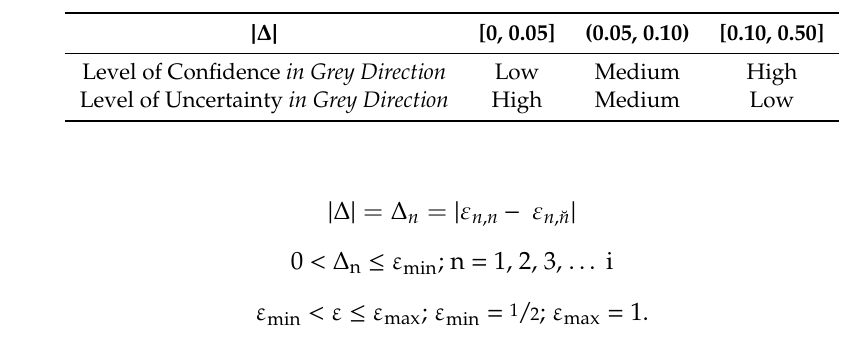
Table 2. The Javed’s confidence level (JCL) scale